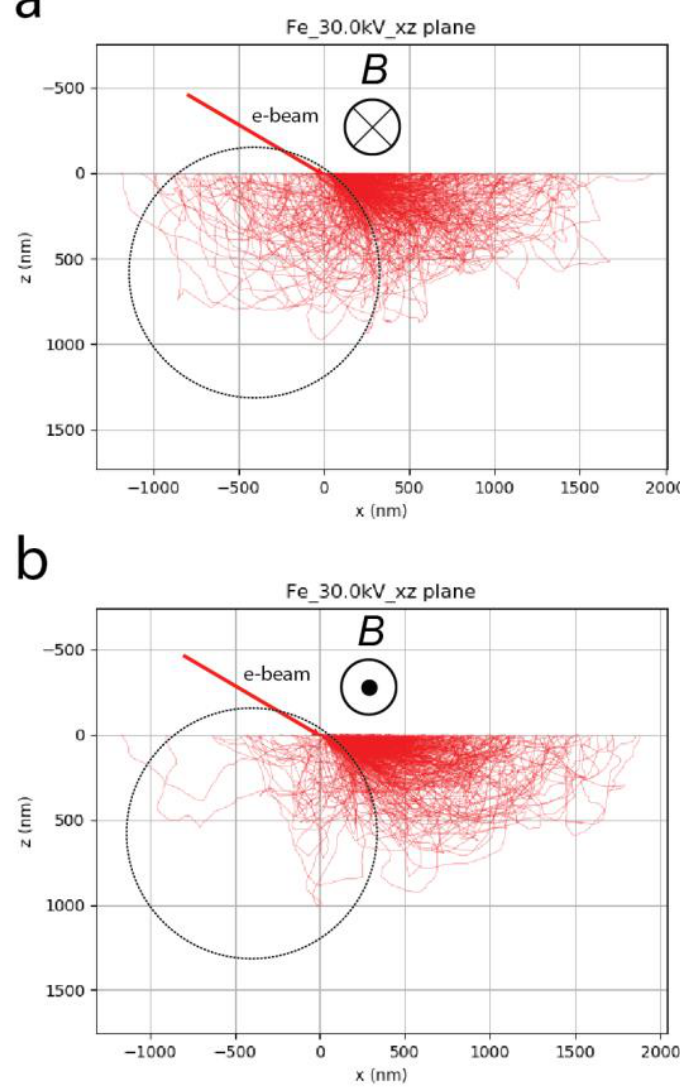
Figure 7. Monte Carlo simulations of electron trajectories in pure iron with 2000 trajectories displayed with the internal magnetic field vector B parallel to the tilt axis pointing in the direction into ( a ) and out of ( b ) the plane of the figure. Tilt angle was 70 ◦ as in a conventional EBSD set-up. The strength of the magnetic induction was deliberately set to 100 T to enhance the magnetic deflection for ease of visualization. The deflection effect of the internal magnetic field of the specimen is clearly seen in the region indicated by the black dotted